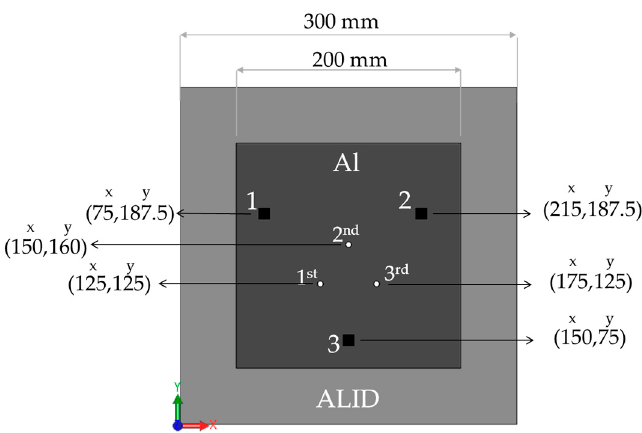
Figure 3. Schematic of the finite element plate. The dimensions of the absorbing boundaries and the locations of the transducers (black squares) and of the holes (white dots) are shown in millimeters. The wave field was simulated successively after adding each defect.